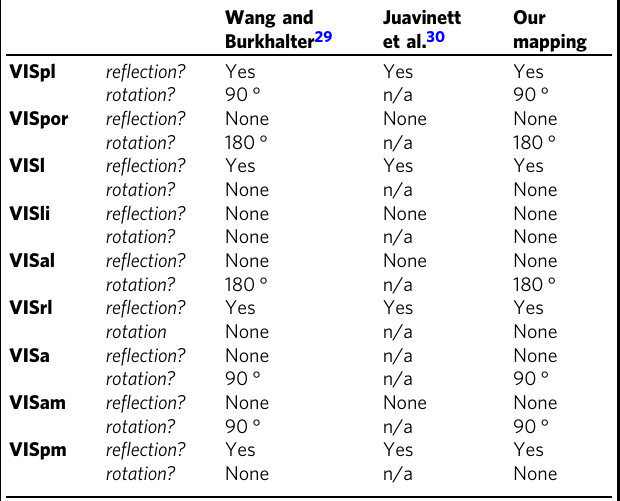
Table 1 Validation of predicted mapping